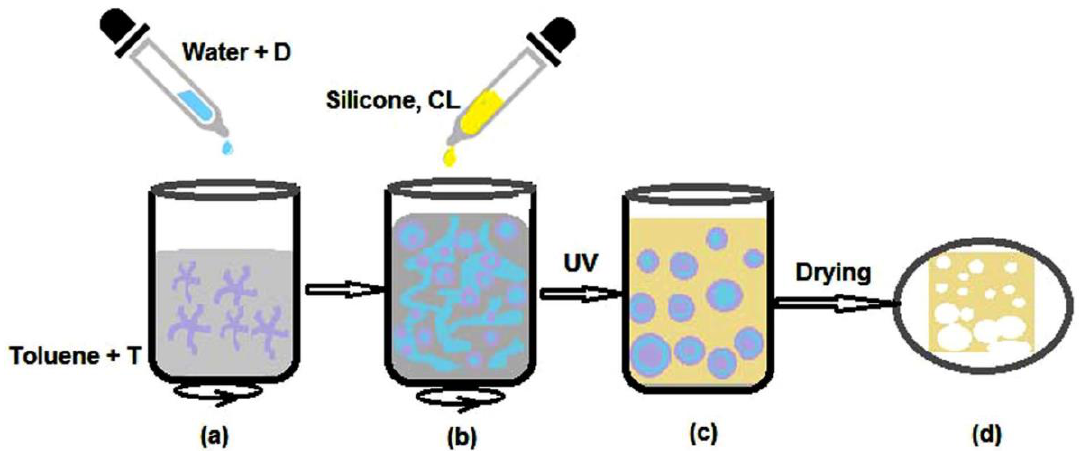
Figure 9. Schematic representation of emulsion templating preparation of porous silicone materials: ( a ) addition of aqueous solution of D into toluene solution of T surfactant; ( b ) formation of complex emulsion structures; ( c ) emulsion gel containing vinyl – polysiloxane, the thiol cross-linker and the initiator, cross-linked under UV irradiation; ( d ) porous monolith after drying. (The T surfactant and the w/o interface were drawn in purple, and the water phase in blue).